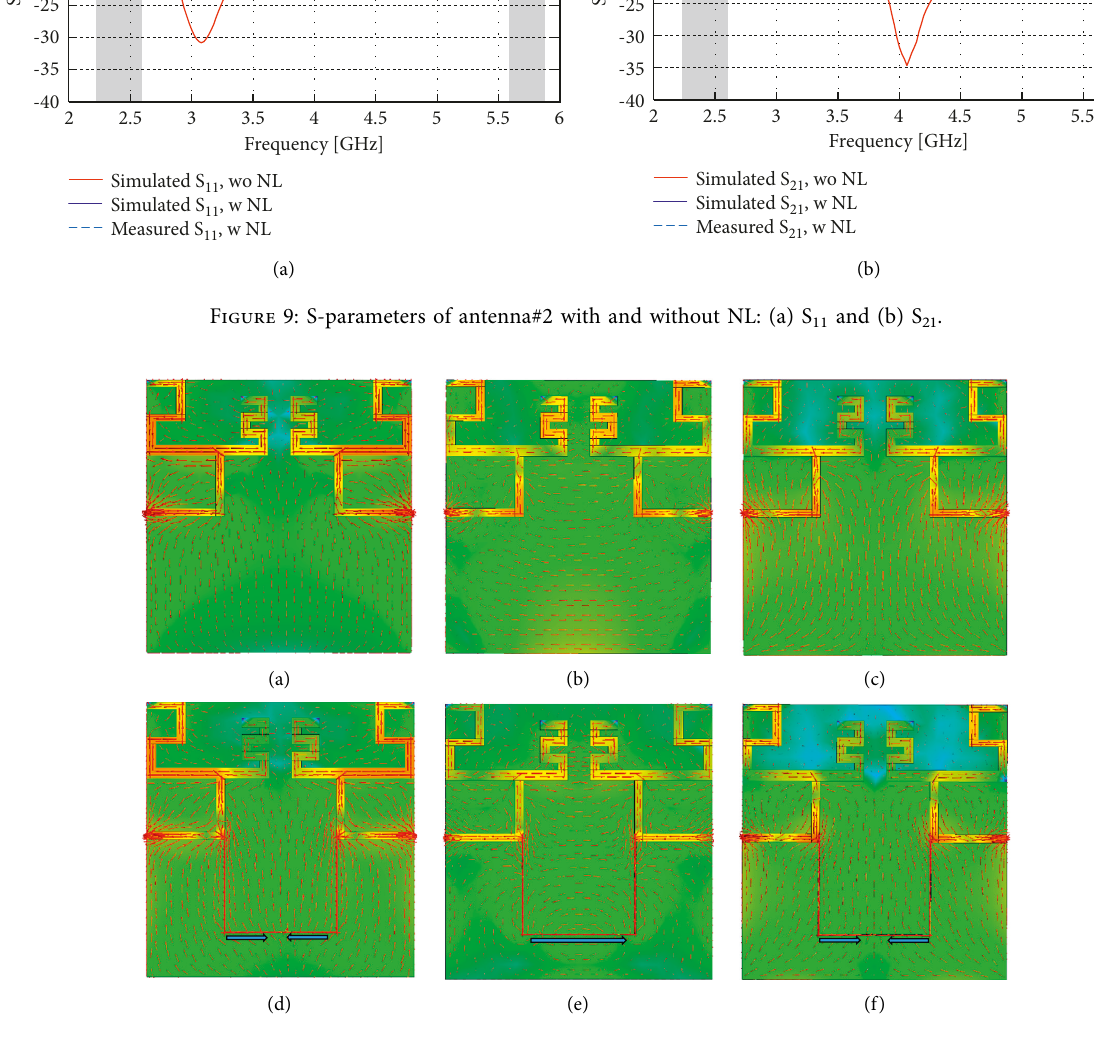
Figure 10: Characteristic current distribution of the significant modes of antenna#2: (a) mode 1 at 2.45GHz, (b) mode 2 at 5.8GHz, (c) mode 3 at 5.8 GHz, (d) mode 1 at 2.45 GHz, (e) mode 2 at 5.8GHz, and (f) mode 3 at